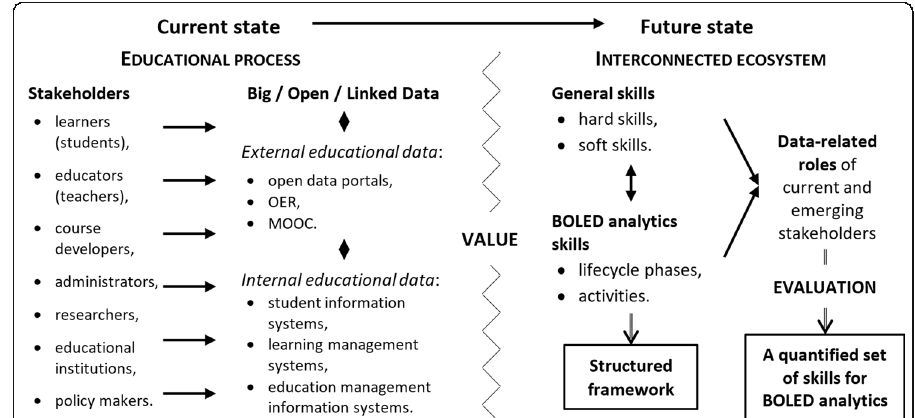
Fig. 1 BOLED analytics – research gaps (emphasized by